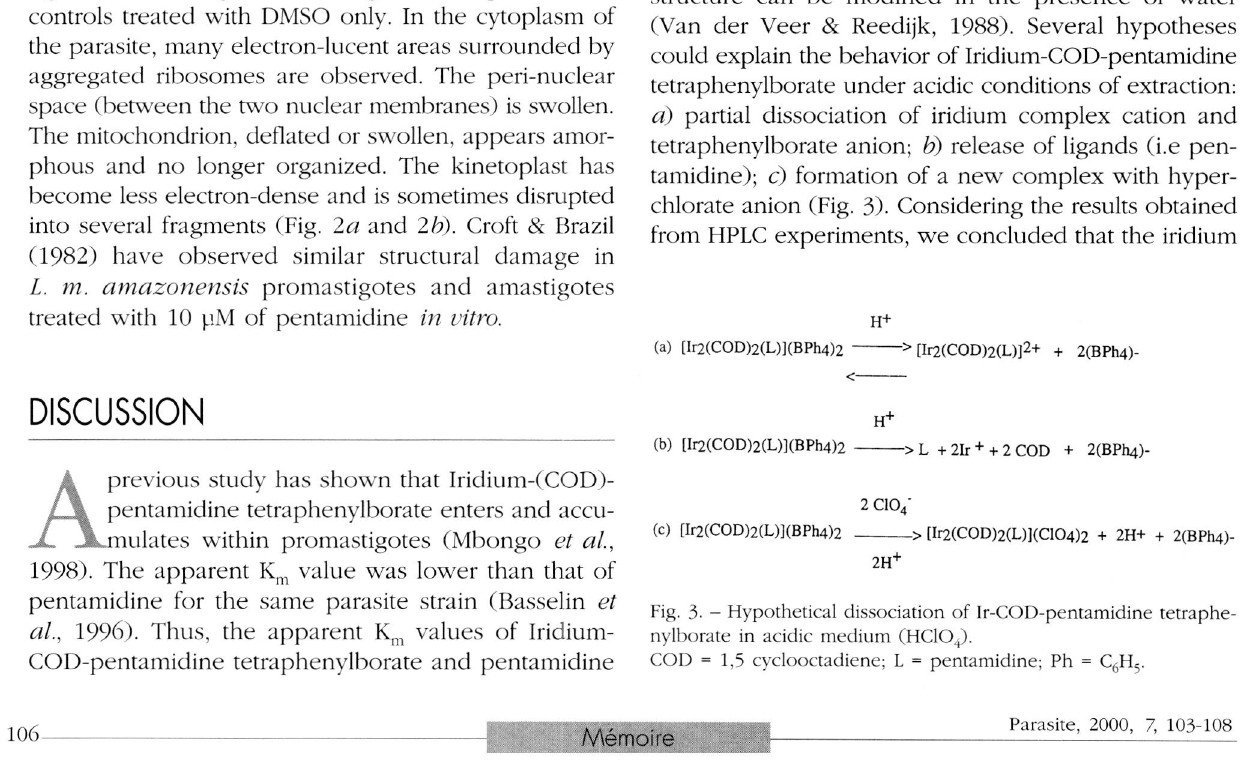
). 4 H . 6 5 Parasite, 2000, 7,